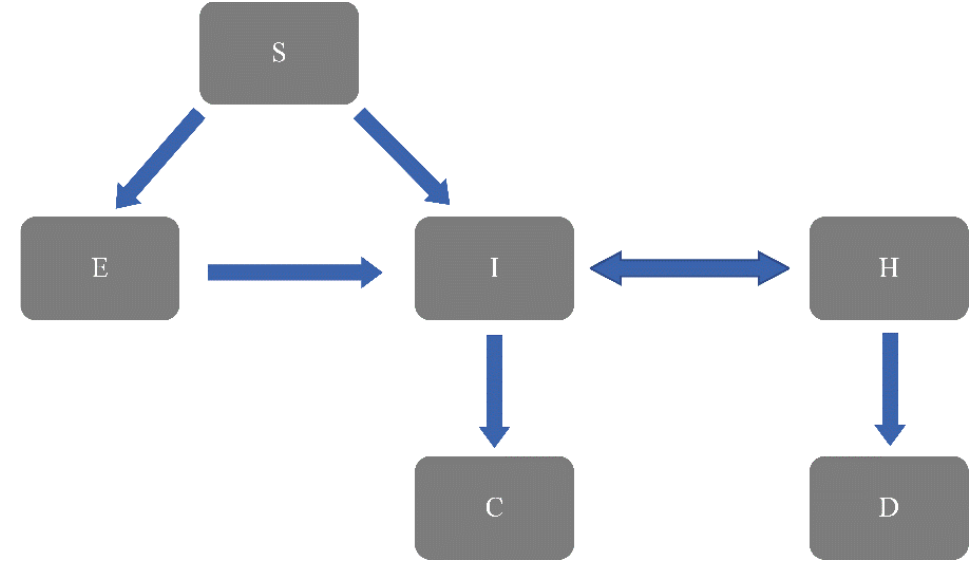
Figure 3. Diagram of the improved SEIR